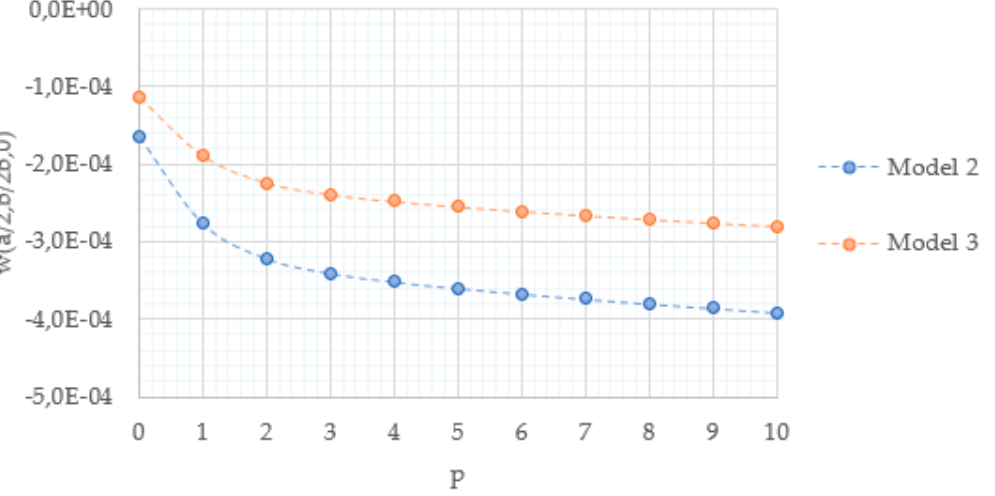
Figure 14. Evolution of the plate’s center transverse displacement with the power law exponent.